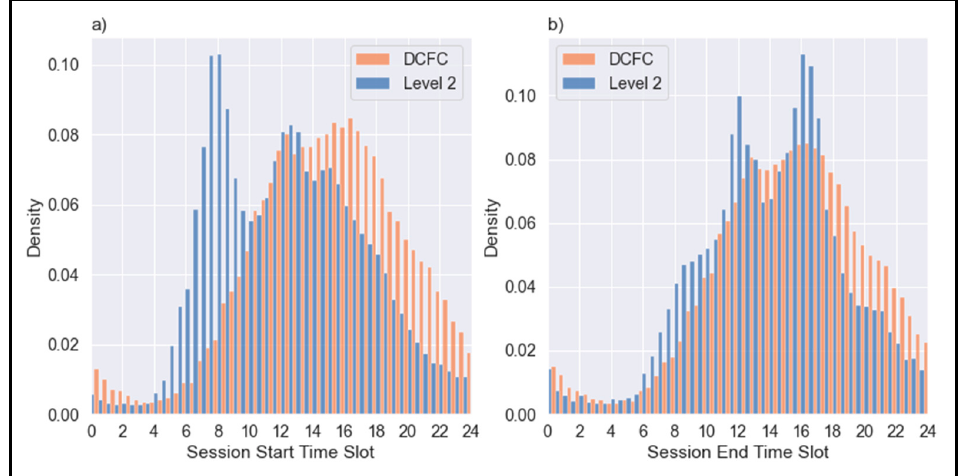
Figure 7. Distribution of DCFC and Level 2 charging event counts over ( a ) session starts and ( b ) session ends.